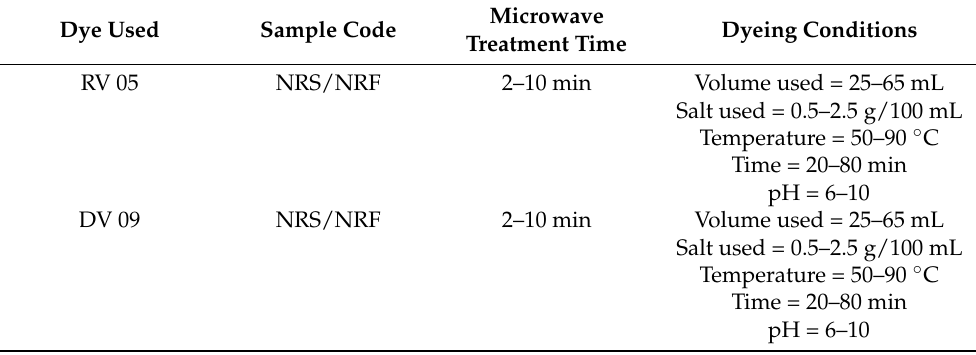
Table 1. Irradiation and dyeing condition for cotton fabric using Reactive Violet 05 and Direct Violet 09